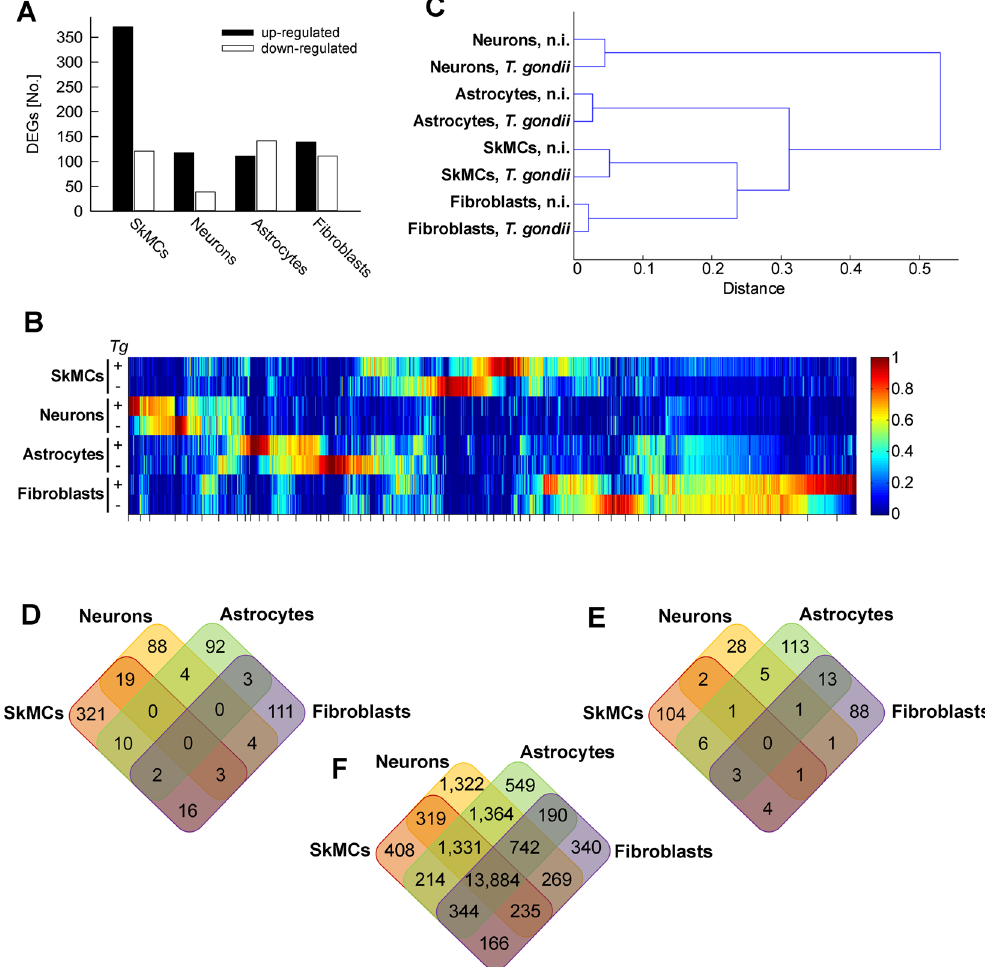
Figure 1. Host cell type-specific responses of mouse SkMCs, neurons, astrocytes and fibroblasts to infection with T. gondii . Mature C2C12 myotubes, cortical neurons and astrocytes, and NIH/3T3 fibroblasts were infected with T. gondii at a MOI of 5:1 for 24 hours or were left non-infected. Pools of total RNA from four different biological replicates each were used to prepare cDNA libraries which were then sequenced using Illumina technology. Reads were mapped to the Mus musculus reference genome. ( A ) Numbers of differentially expressed genes (DEGs) which were up- or down-regulated ( > 2-fold, p < 0.05) after T. gondii infection as compared to the respective non-infected control. ( B ) Heatmap of DEGs after infection of SkMCs, neurons, astrocytes and fibroblasts with T. gondii . Expression profiles were clustered according to a one-dimensional self-organizing map. ( C ) Hierarchical cluster analysis of genes which were differentially expressed after T. gondii infection in at least one host cell type. ( D ) Venn diagram of genes up-regulated ( > 2-fold, p < 0.05) by T. gondii in at least one of the four host cell types. ( E ) Venn diagram of genes down-regulated ( > 2-fold, p < 0.05) by T. gondii in at least one of the four host cell types. ( F ) Venn diagram of genes expressed in any of the four different non-infected host cell